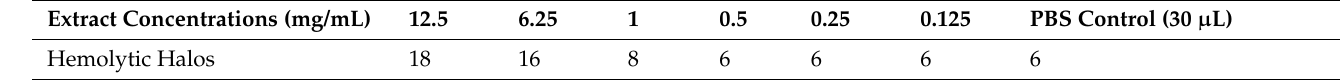
Table 8. Hemolytic properties of the aqueous extract of T. ciliata root bark on human erythrocytes.